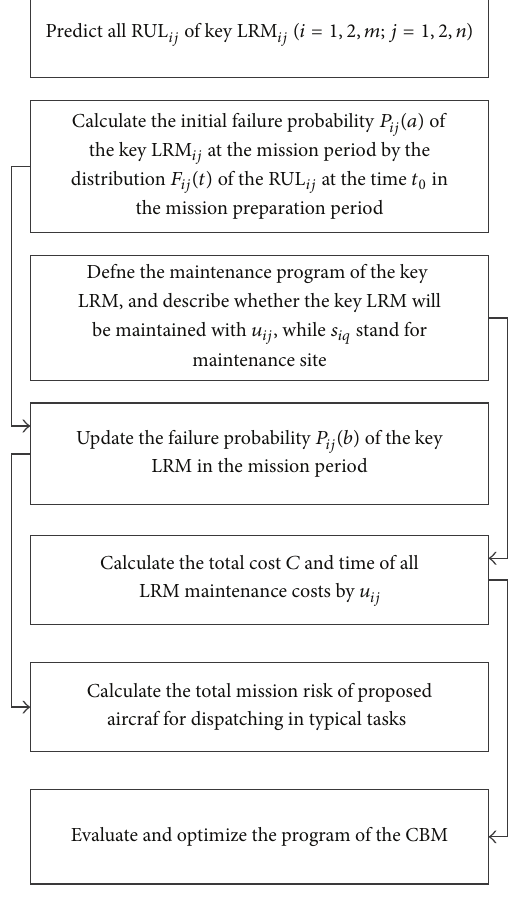
Figure 2: Modeling framework for CBM of aircraft